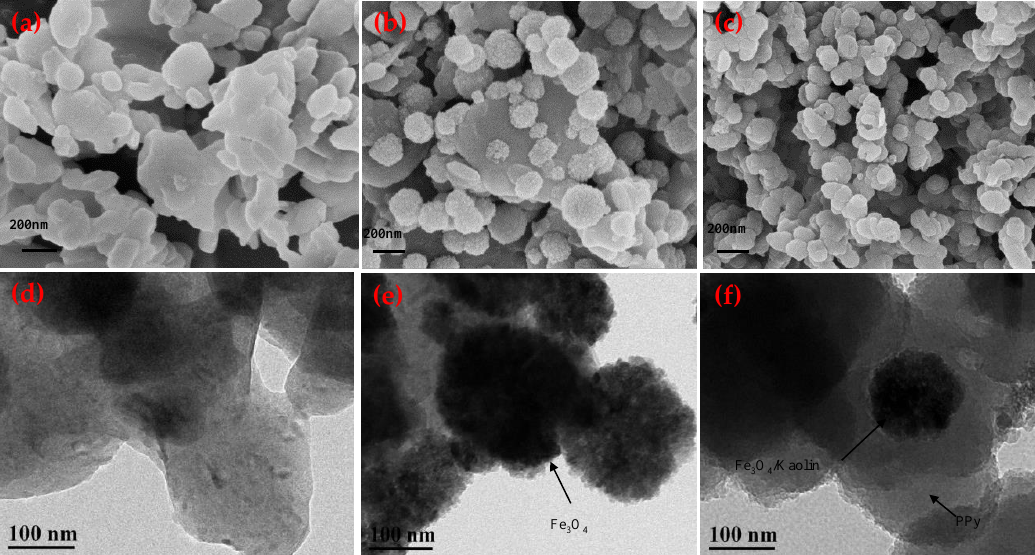
Figure 2. SEM images of ( a ) Kaolin, Magnification: 50,000 × , ( b ) Fe 3 O 4 / Kaolin Magnification: 50,000 × and ( c ) PPy-Fe 3 O 4 / Kaolin, Magnification: 20,000 × ; TEM images of ( d ) Kaolin, ( e ) Fe 3 O 4 / Kaolin, and ( f )